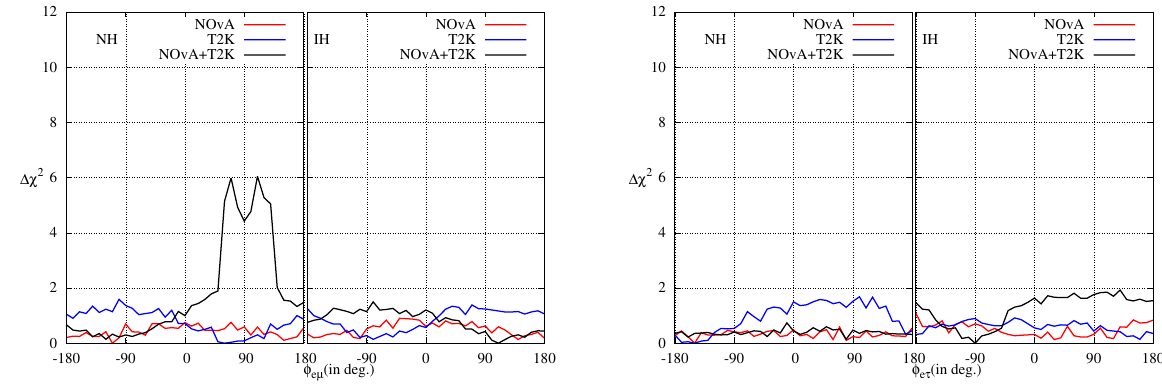
Figure 11. ∆ χ 2 as a function of individual LIV parameters.